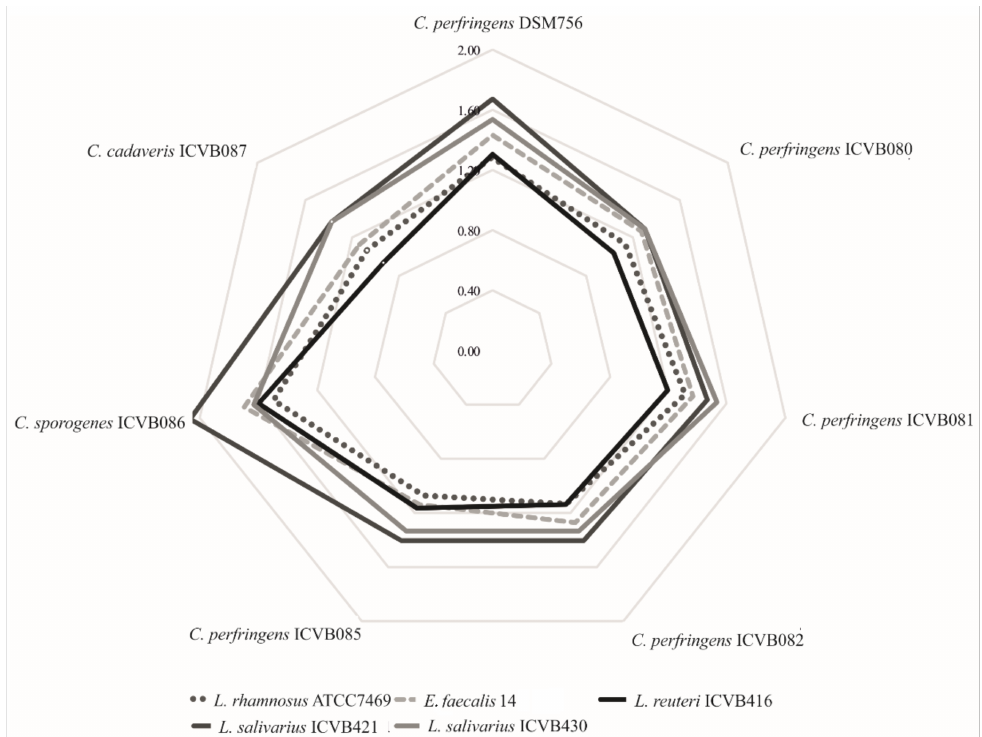
Figure 1. Anti- Clostridium activity depicted as a spider chart. Zones of inhibition were assessed by measuring the radius of the halo in cm. Target strains are in the borders and lines show the activity of probiotic candidates.